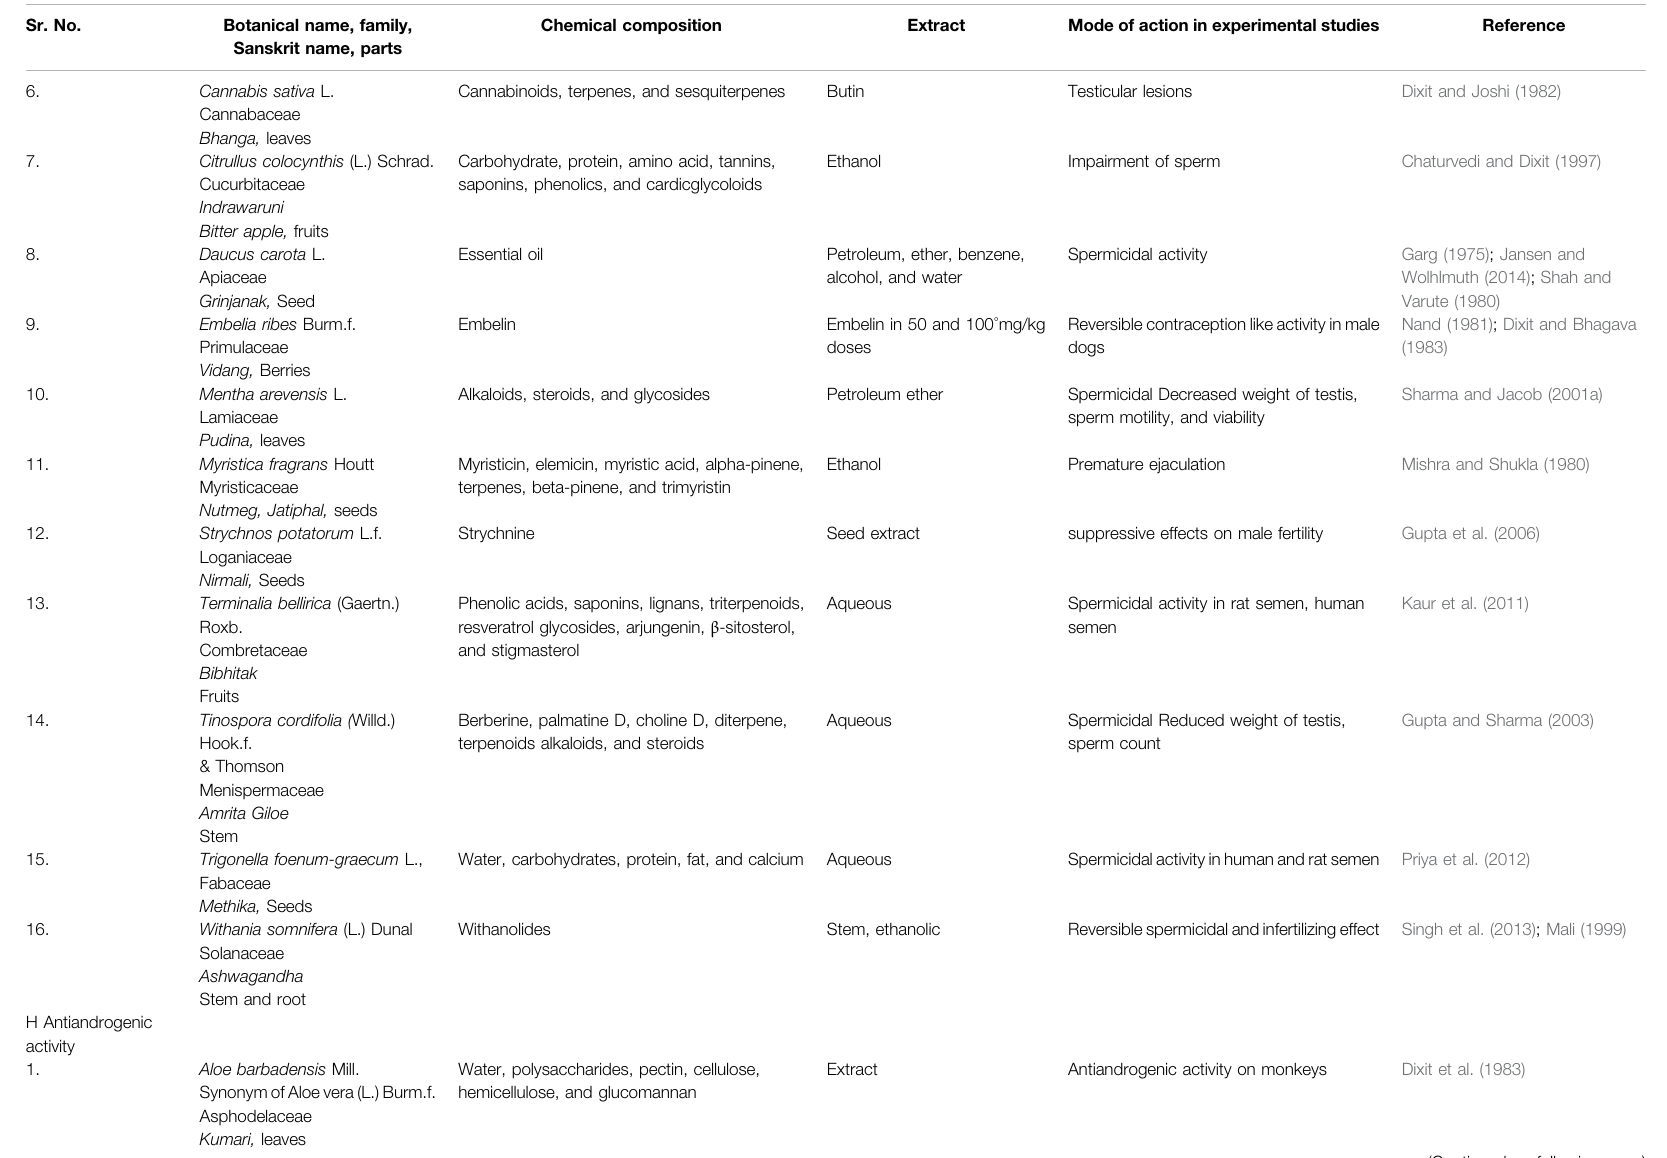
TABLE 2 | ( Continued ) Medicinal plants and their phyotoconstituents validated for various female/male contraceptive activities. Different contraceptive activities studied on medicinal plants could be categorized as follows. Female contraceptive activities: (2A) anti-implantation activity, (2B) aborti fi cation, (2C) antifertility, (2D) antiovulatory, and (2E) antiestrogenic activity. Male contraceptive activities: (2F) antispermatogenic, (2G) spermicidal, and (2H) antiandrogenic